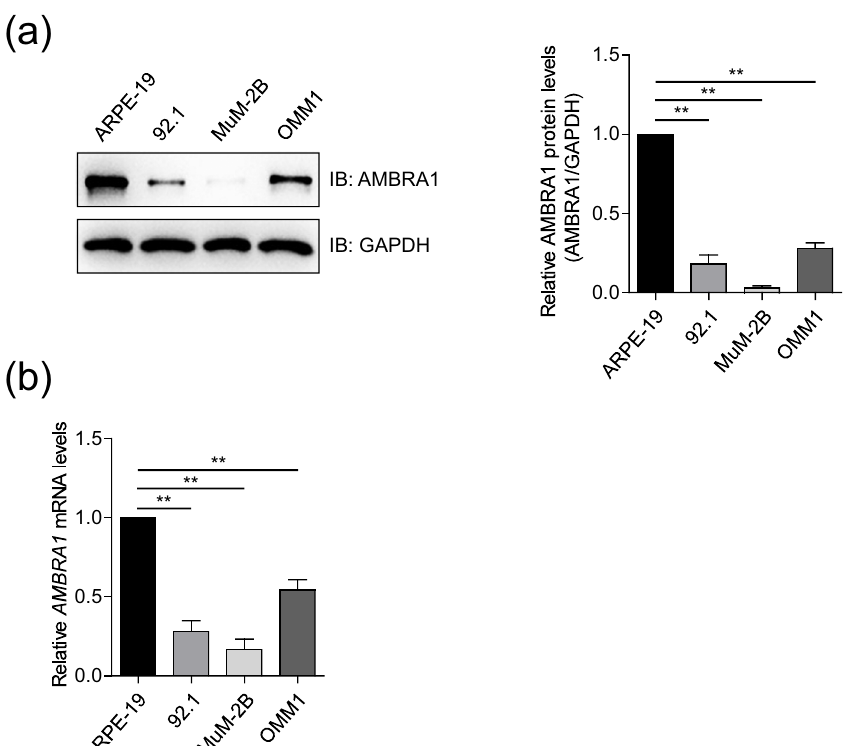
Figure 1: Expression pro fi le of AMBRA1 in human pigment epithelial cells and UVM cells. ( a ) The protein levels of AMBRA1 in human pigment epithelial cells ( ARPE - 19 ) and UVM cell lines ( 92.1, MuM - 2B, and OMM1 ) were detected by immunoblotting analysis. The bands of AMBRA1 were quanti fi ed and compared to that of GAPDH. The data are expressed as mean ± standard deviation ( SD ) and were analyzed using one - way ANOVA with Tukey ’ s post hoc test. **P < 0.01, very signi fi cantly di ff erent, and the experiment was repeated thrice. ( b ) The mRNA levels of AMBRA1 in human pigment epithelial cells and UVM cells were detected by RT - qPCR. Data are expressed as the mean ± SD and were analyzed using one - way ANOVA with Tukey ’ s post hoc test. ** P < 0.01, very signi fi cantly di ff erent, three independent